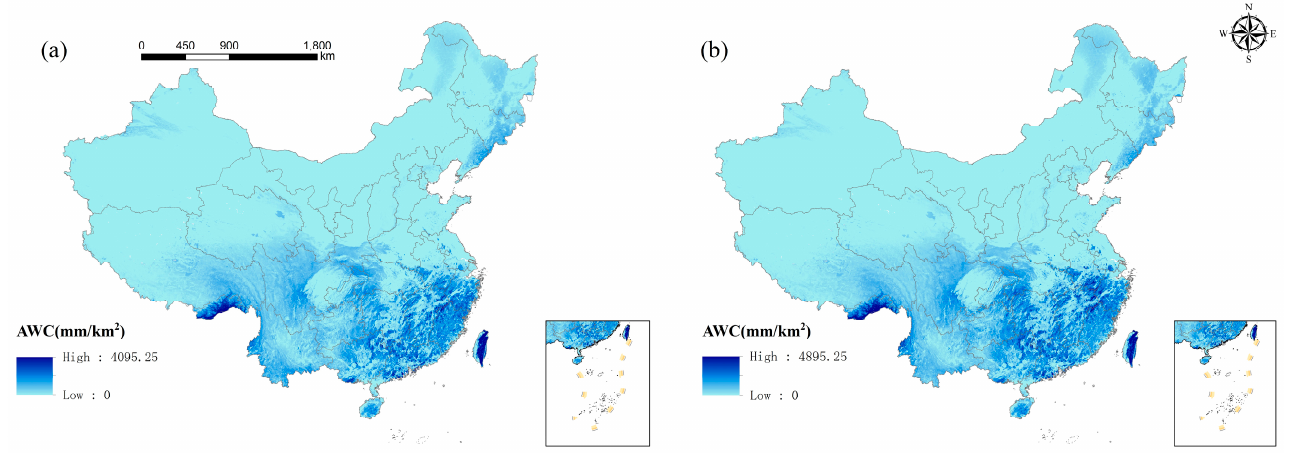
Figure 3. Temporal and spatial evolution of water conservation function in China. ( a ) Water conservation in 2005 ; ( b ) Water conservation in 2020.